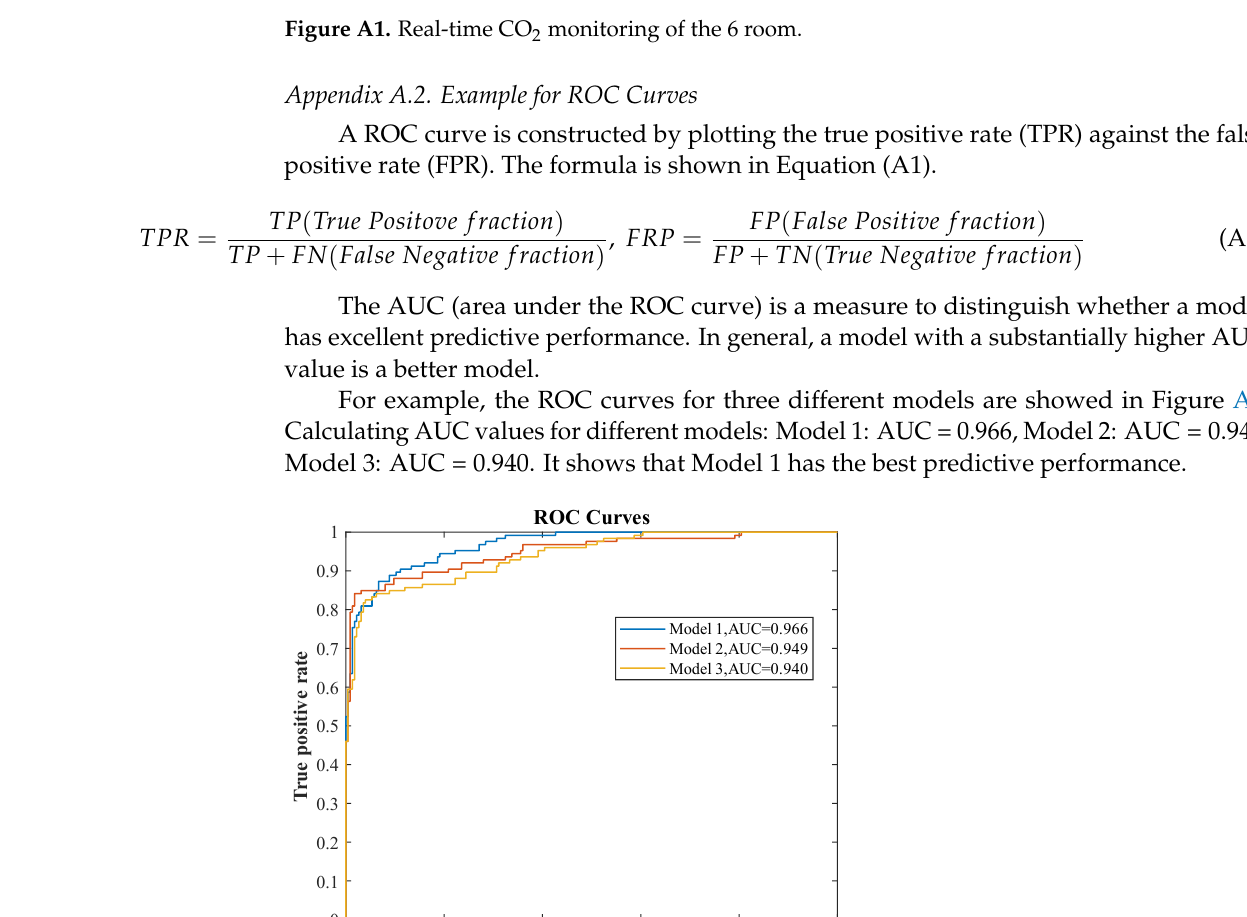
Figure A2. ROC curves for different models.